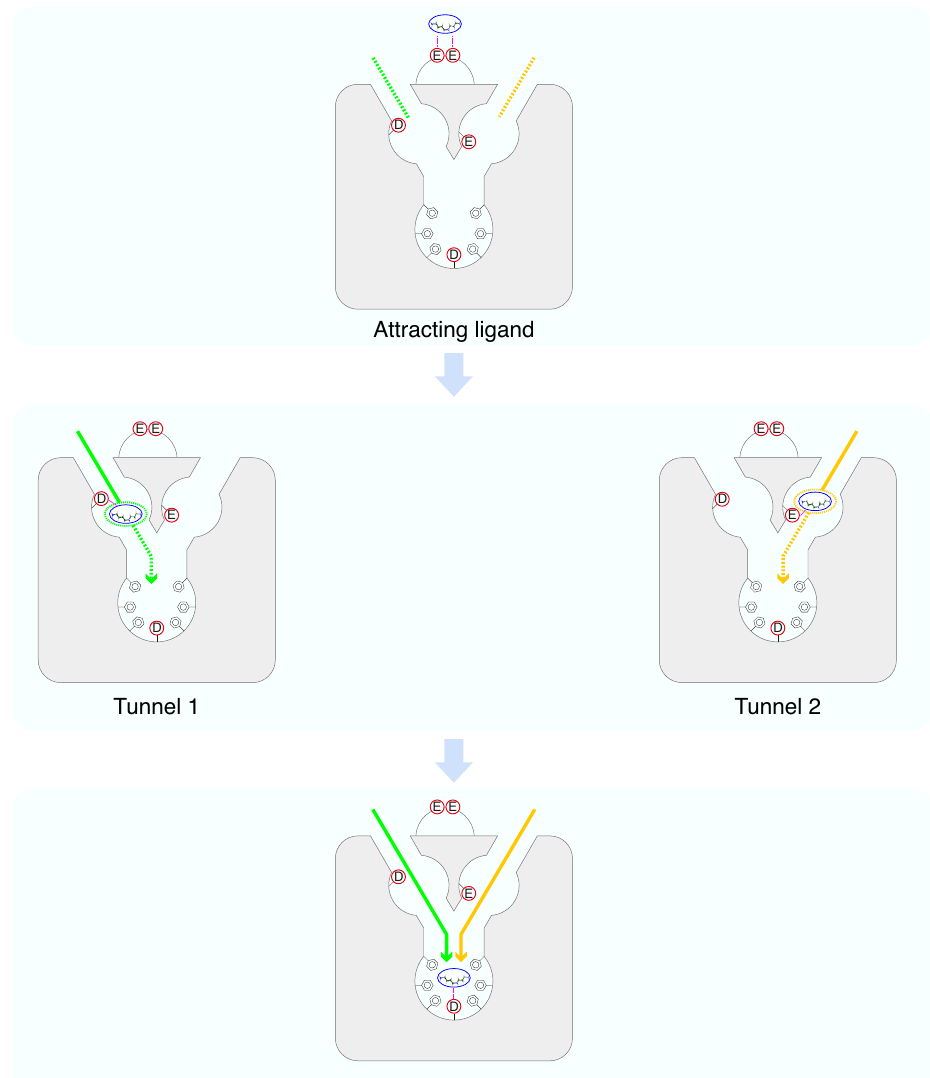
Figure 5. Schematic illustration of ligand-binding process of TAAR9. Firstly, the negative-charged glutamates in ECL2 attract the positive-charged amine to approach the opening of tunnels in the receptor (top). Then the amine ligand can enter either vestibular binding pocket 1 through Tunnel 1 (green) interacting with D 6.58 (middle left), or vestibular binding pocket 2 through Tunnel 2 (yellow) interacting with E 7.36 (middle right). Both tunnels lead to the orthosteric binding pocket, where the amine ligand can bind firmly with D 3.32 and gets stabilized with surrounding residues having aromatic rings